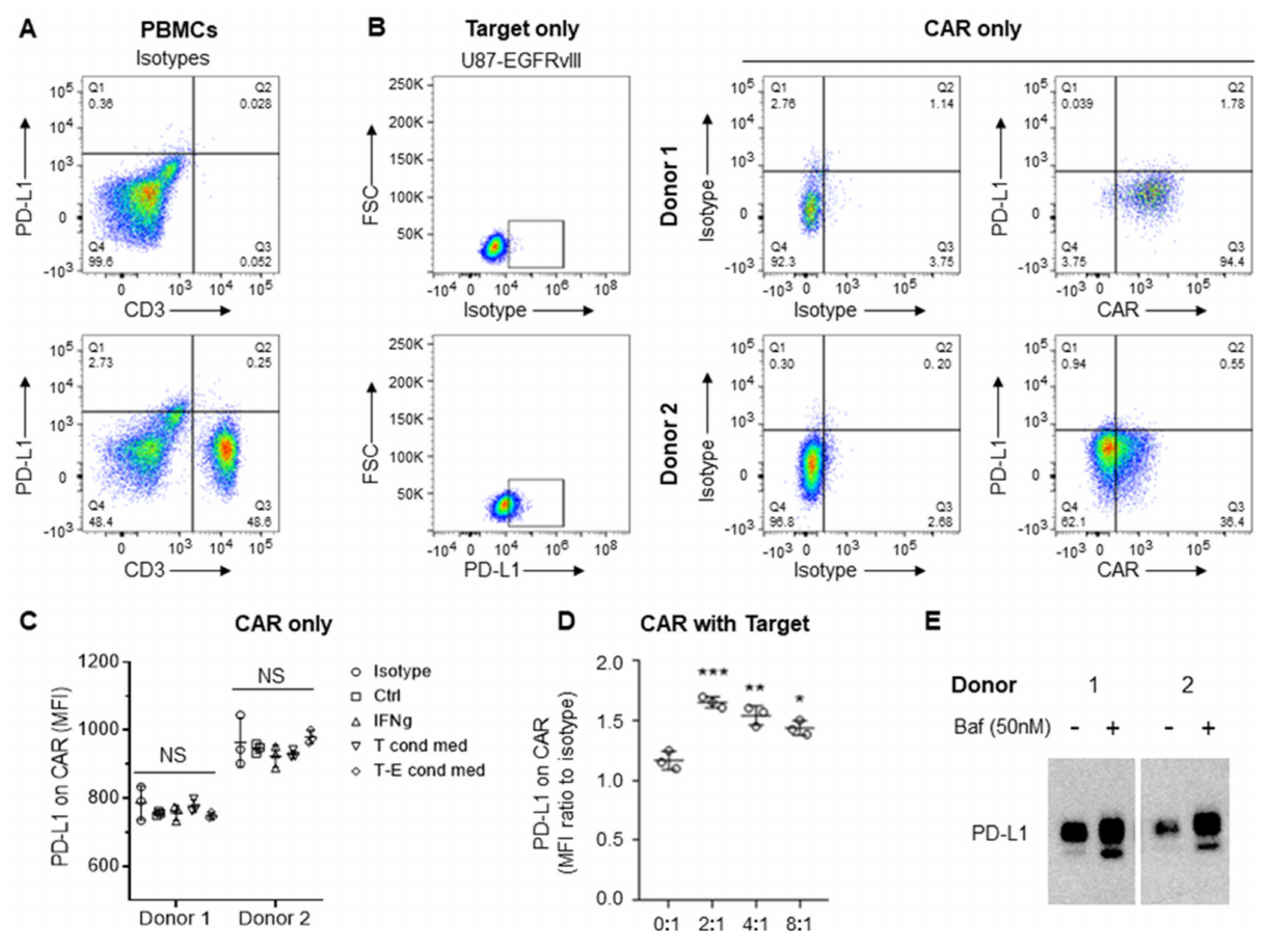
Figure 6. Expression of PD-L1 on target tumor but not on CAR T cells. ( A ) Flow cytometry analysis of baseline PD-L1 expression on CD3+ primary T cells from peripheral blood mononuclear cells (PBMCs). Analysis was conducted in triplicates. ( B ) Flow cytometry analysis of target tumor (U87- EGFRvIII) and EGFRvIII CAR T cells. ( C , D ) Summary of flow cytometry analysis of PD-L1 levels (MFI, mean fluorescence intensity) on CAR T cells expanded on anti-CD3/CD28 dynabeads (Ctl), treated with interferon γ (IFN γ , 5 ng/ml), exposed to condition media from the target (T cond med) or target-CAR (T-E = 2:1) conditioned media ( D ). Summarized flow cytometry analysis of PD-L1 on CARs after co-culture with target tumor for 20 h, taken from biological replicates of Donor 1. Targets and CARs are distinct populations gated on SCC/FSC, GFP (targets), and CAR (CD3). * p < 0.05; ** p < 0.01; *** p < 0.001 relative to no target. ( E ) Western blot analysis of PD-L1 expression on EGFRvIII-specific CARs generated by Donors 1 and 2 following CAR-target co-culture for 20 h in the absence (-) or presence (+) of bafilomycin (Baf). Original flow cytometry see Supplementary Figure S1. Original blots see Supplementary Figure